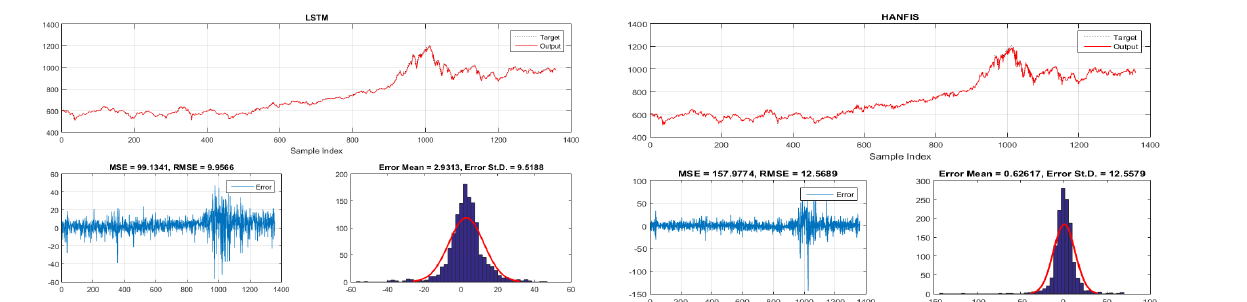
Fig. 15. VN Index forecasting performance by LSTM model: (a) forecasting and actual values, (b) error value and (c) standard deviation